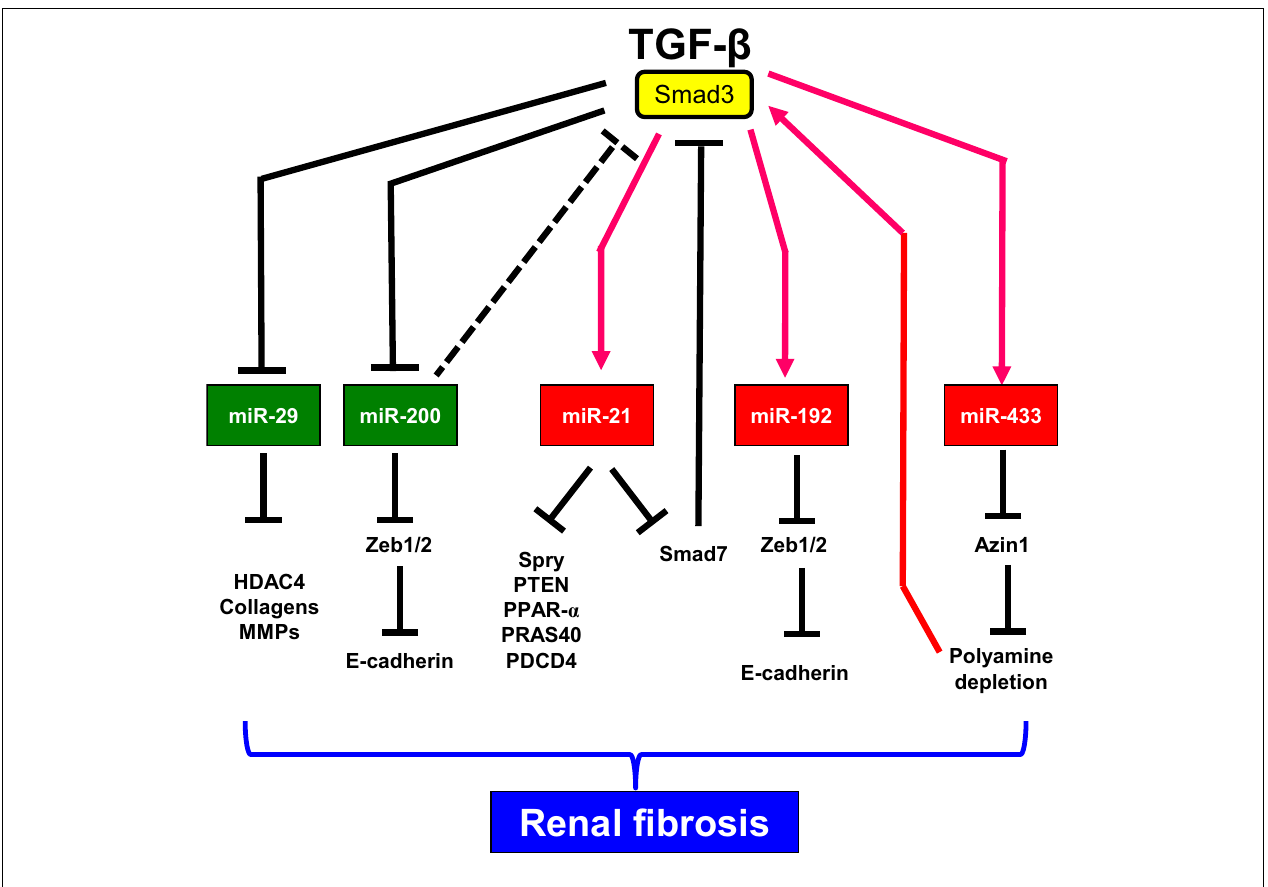
FIGURE 1 | Mechanisms of TGF- β -regulated miRNAs in renal fibrosis. TGF- β promotes fibrosis by inducing miR-21, miR-433, and miR-192 but suppressing miR-29 and miR-200 during renal injury. miR-192, miR-433, and miR-21 play a pathological role in kidney fibrosis through a feed-forward loop